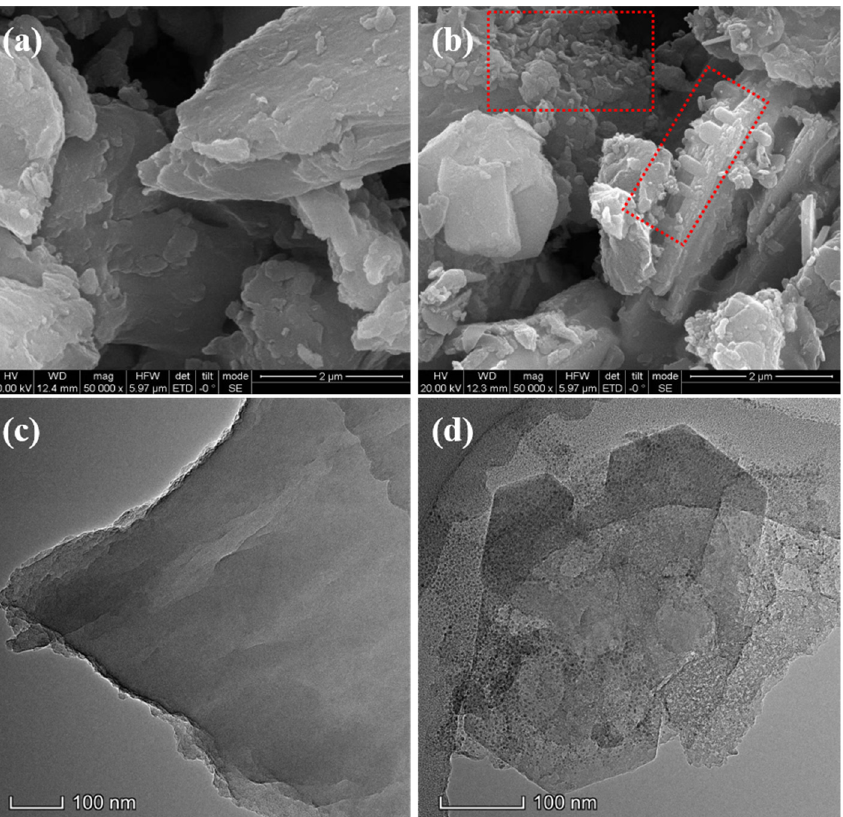
Figure 1. SEM images of ASBC400 ( a ), ASBC800 ( b ), and TEM images of ASBC400 ( c ) and ASBC800 ( d